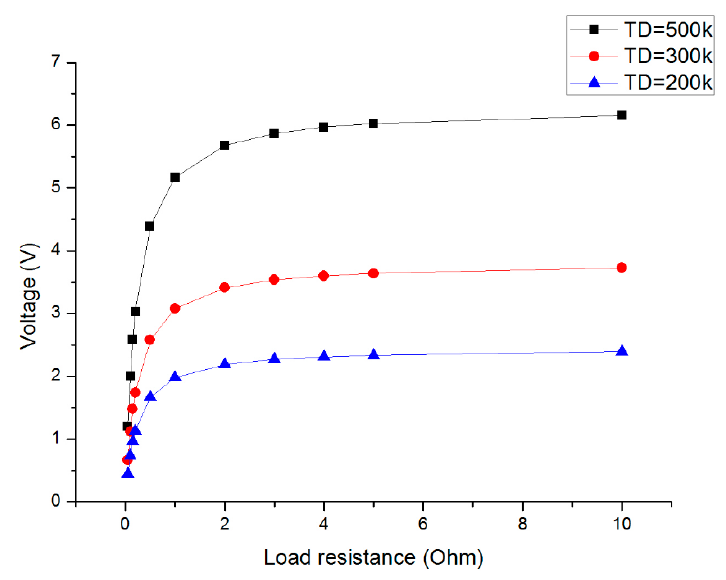
Figure 9. Output voltage versus load resistance.